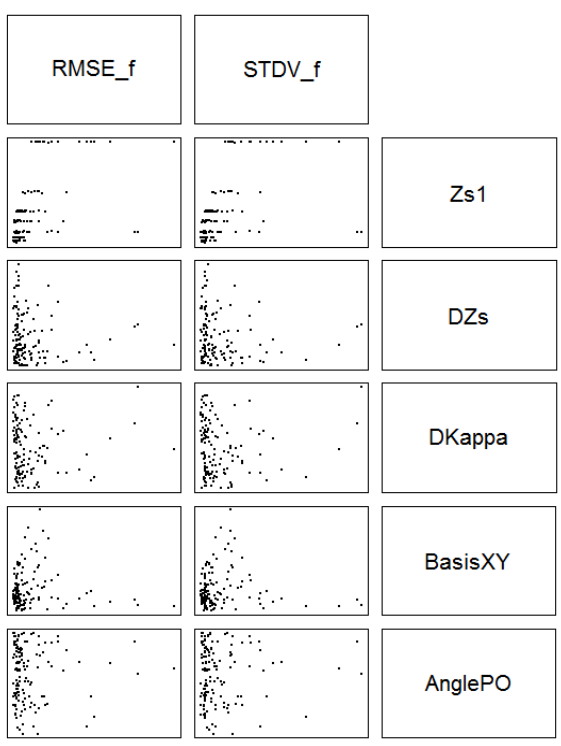
Figure 7. Scatterplot matrix showing the relationship between the error values RMSE and stdv against different parameters. Zs1: flight altitude, DZs: difference in flight altitude, DKappa: difference in yaw angle, BasisXY: photo base, AnglePO: difference in viewing angle.